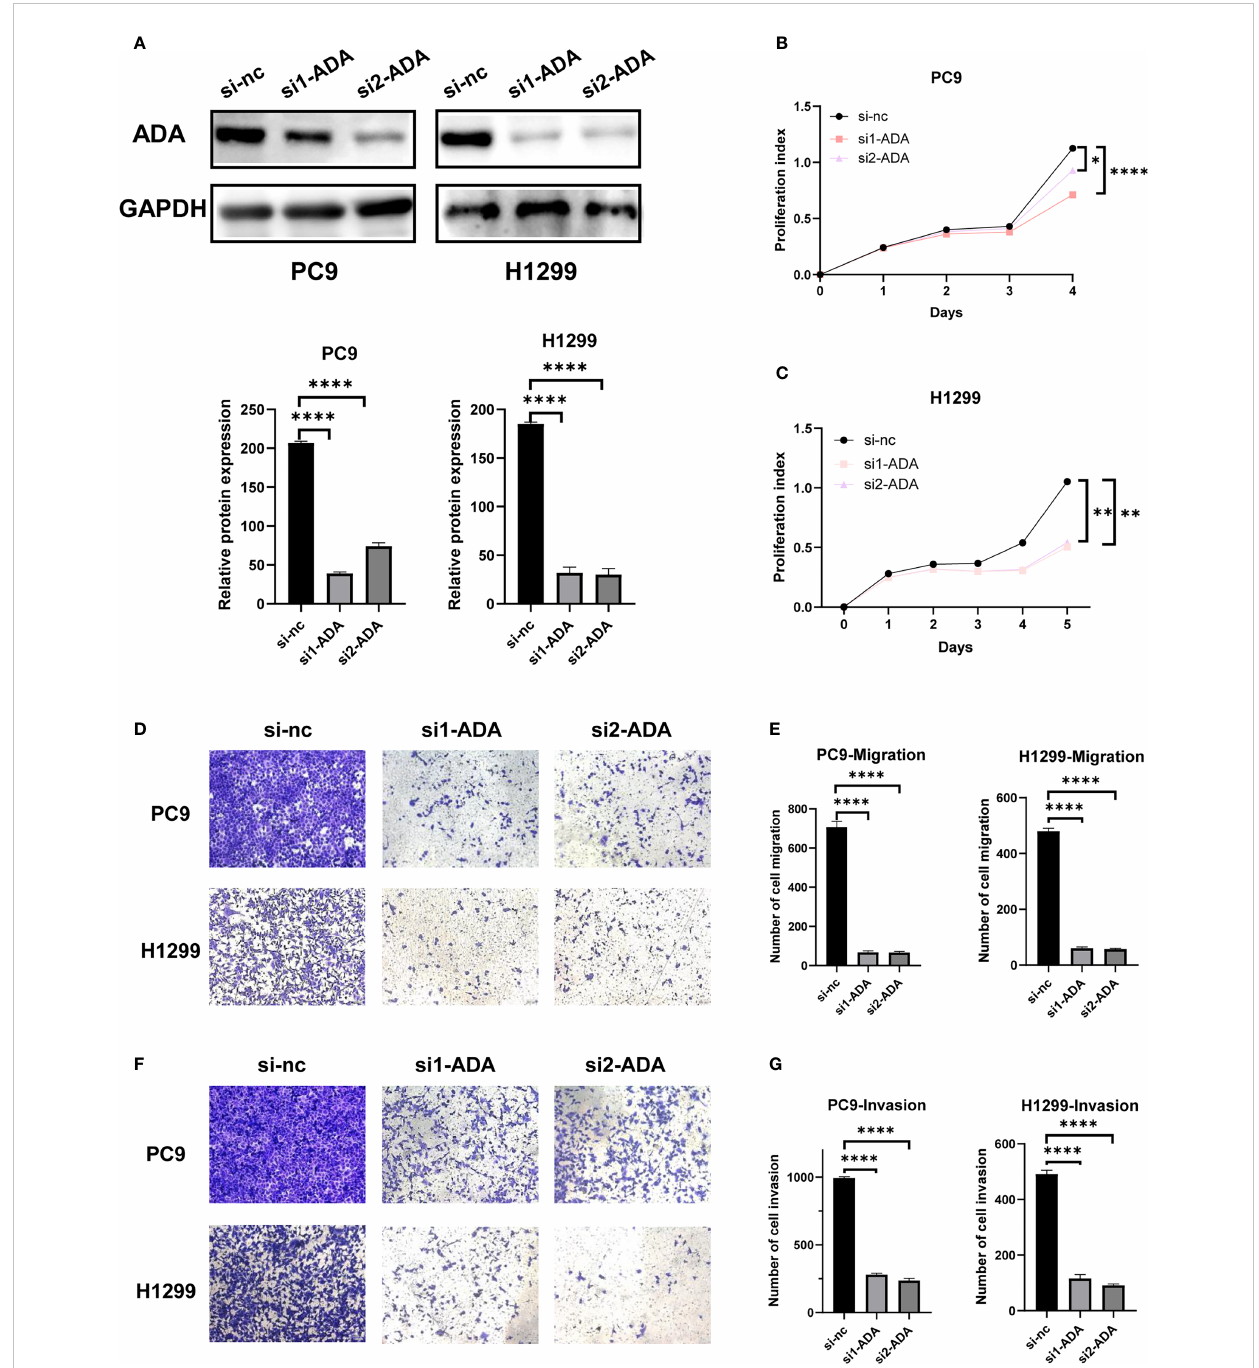
FIGURE 8 Experimental validation of the role of ADA in LUAD cell lines. (A) The knocking down ef fi ciency by speci fi c siRNA against ADA was con fi rmed by western blot. (B, C) The proliferation ability of PC9 and H1299 cells was measured by the CCK-8 assay after transfecting ADA siRNAs. PC9 and H1299 cell migration assay (D, E) and invasion assay (F, G) were performed in control and siADA groups. *p < 0.05; **p < 0.01; ****p < 0.0001. nc: negative